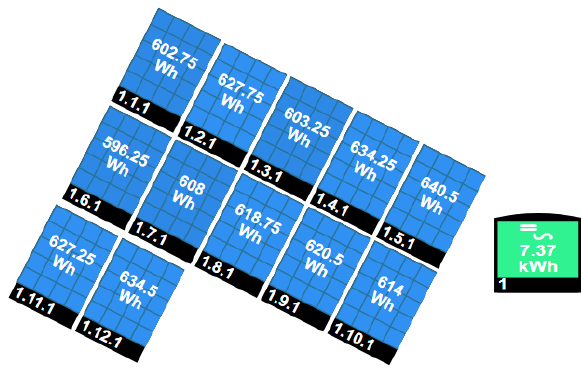
Figure 3: Production of electricity by individual panels in the system